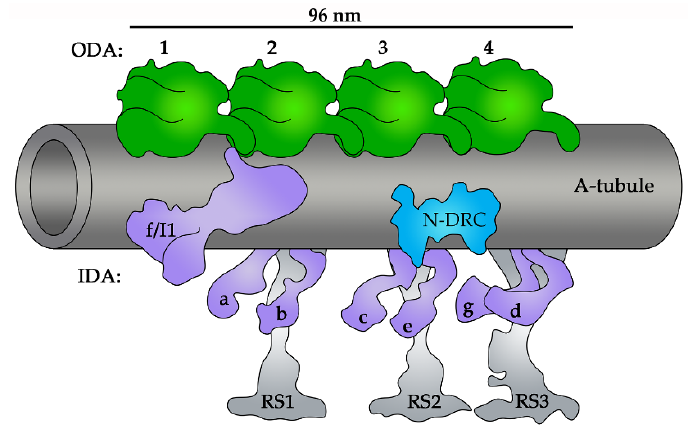
Figure 2. A schematic representation of the organization of macro-complexes within the 96 nm axonemal unit: ODAs (outer dynein arms, in green), IDAs (inner dynein arms, in violet), RSs (radial spokes, in grey), and the N-DRC (nexin–dynein regulatory complex, in blue) [4].